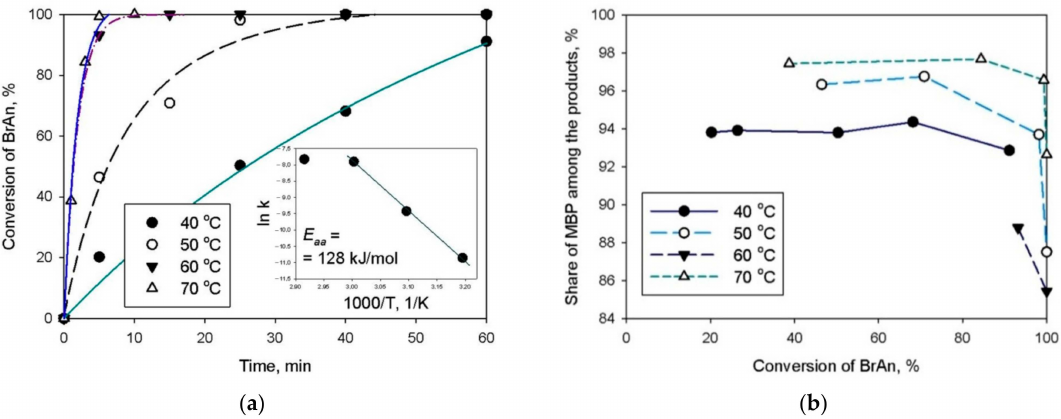
Figure 10. Influence of temperature on the dependence of BrAn conversion vs. time ( a ) and on the “selectivity” with respect to MBP ( b ): 1 mmol of BrAn, 2.5 mmol of PBA, 3.0 mmol of NaOH, 900 rpm, and 30 mg of reduced